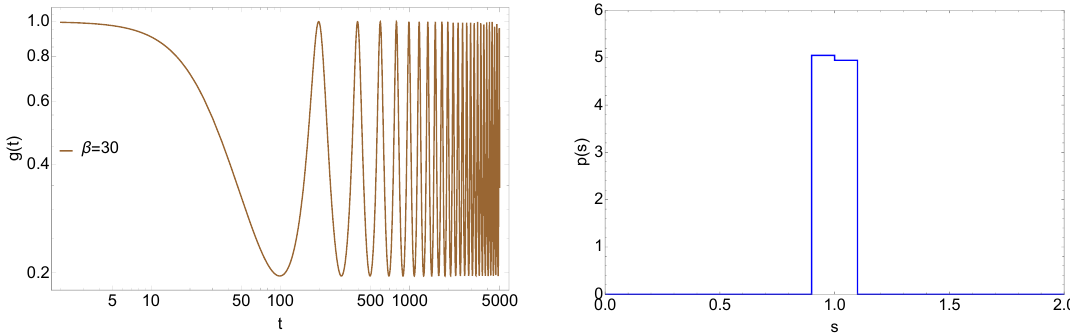
Figure 3. SFF (left) and corresponding level spacing distribution (right) for BTZ black hole normal modes with z = 30 , β = 30 , n = 200 and J is fixed to one. Bin size on the right is 0 . 1 . 0 cut